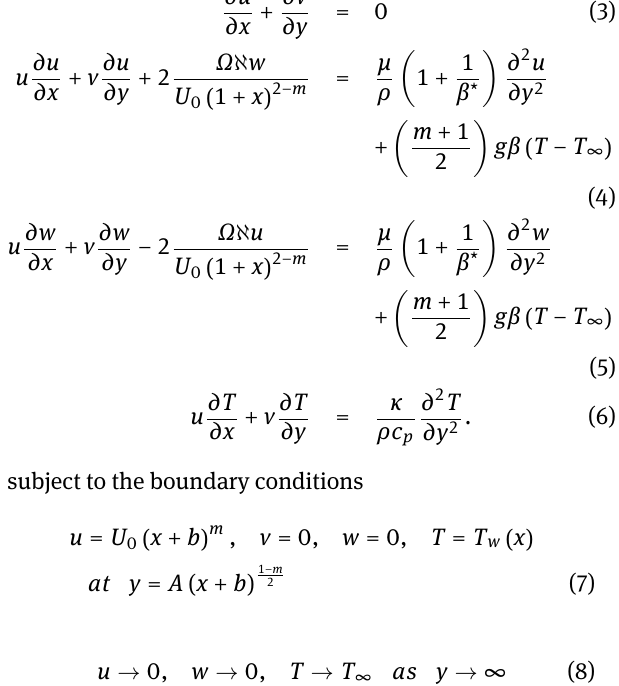
Figure 1: Physical Configuration in xy